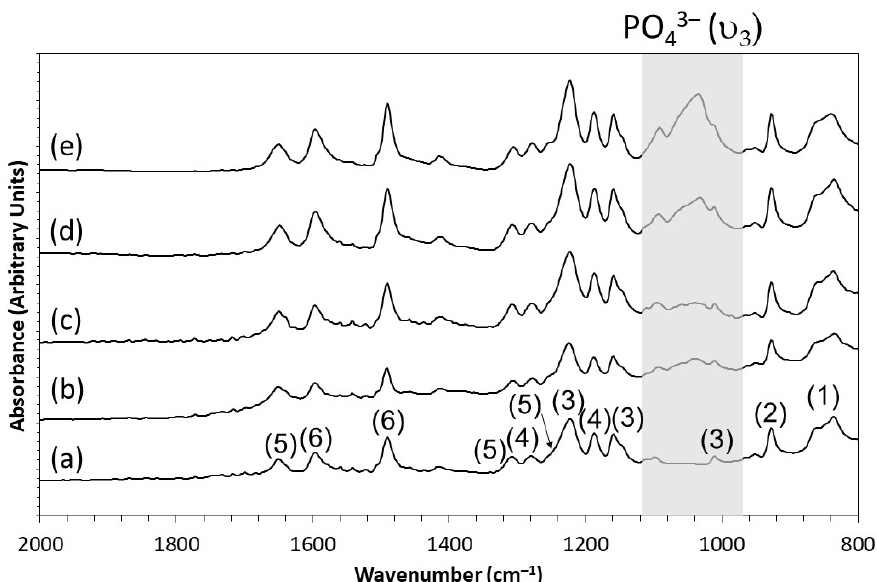
Figure 2. FTIR spectra for ( a ) 0HA, ( b ) 5HA, ( c ) 10HA, ( d ) 20HA, and ( e ) 30HA. Key for figure: (1)—Out of plane, aromatic hydrogen, (2)—Diphenyl ketone band, (3)—In plane, aromatic hydrogen, (4)—Diphenyl ether groups, (5)—Carbonyl group, and (6)—Skeletal phenyl ring. The key PO 43 − ( υ 3 ) peaks of HA are highlighted in the grey shaded area.